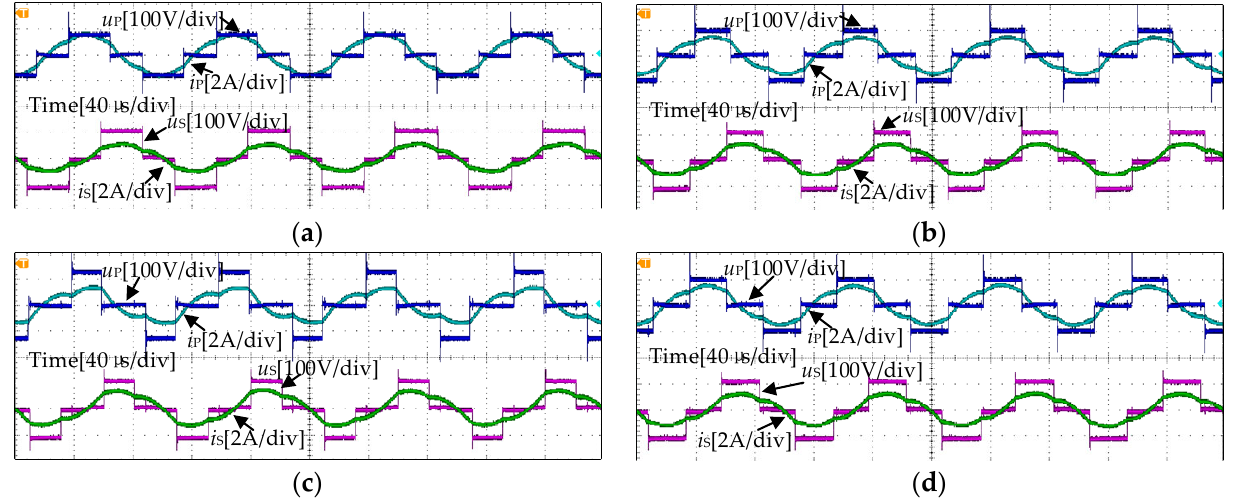
Figure 13. The steady-state experimental waveforms with the proposed VDCC method: ( a ) U in = 80 V, R = 50 Ω ; ( b ) U in = 100 V, R = 50 Ω ; ( c ) U in = 130 V, R = 50 Ω ; ( d ) U in = 160 V, R = 45.4 Ω .